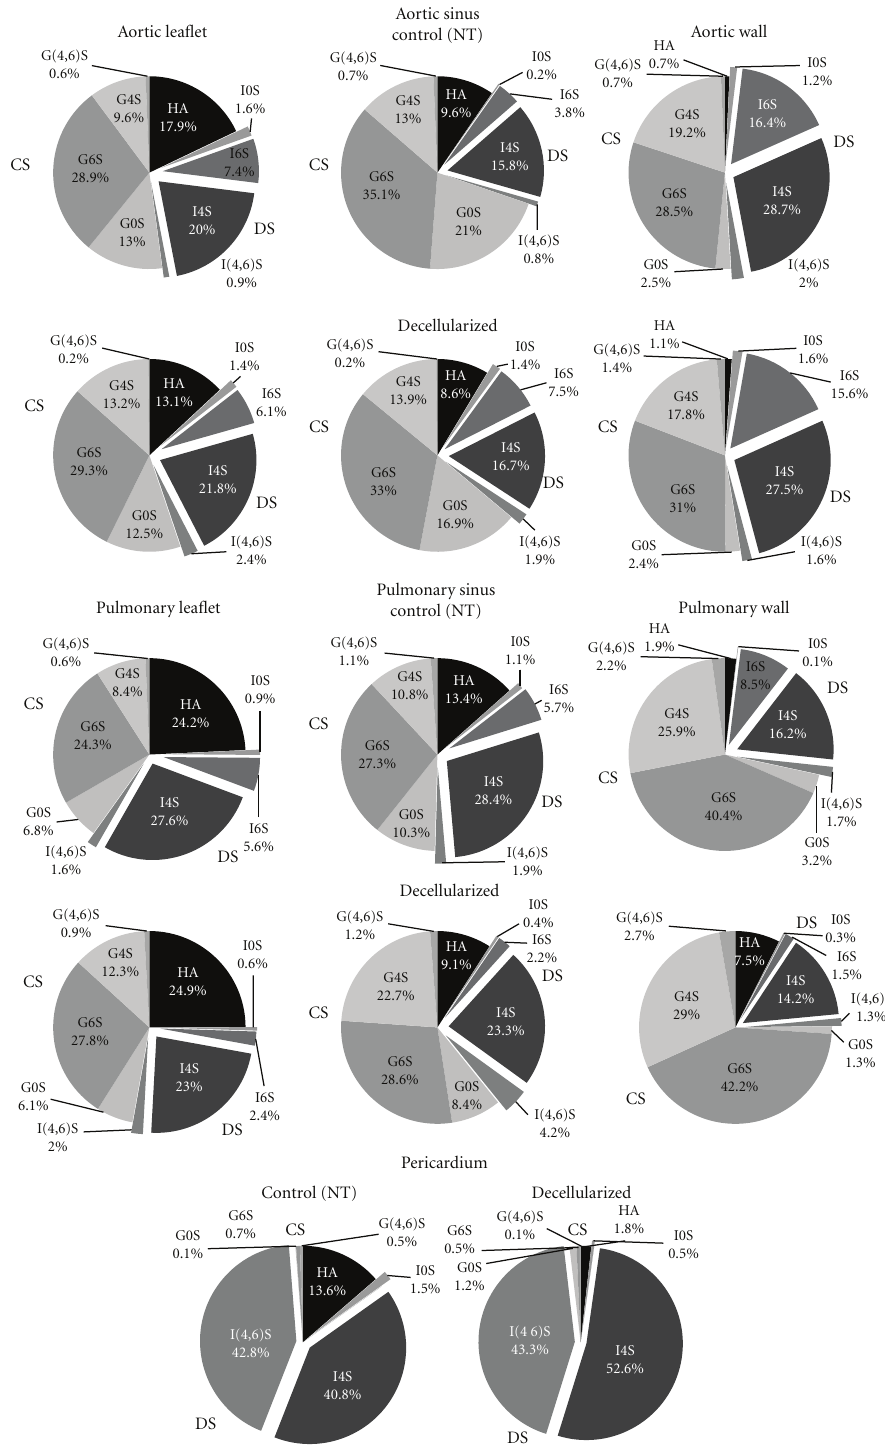
Figure 3: Distribution of glycosaminoglycans (GAGs) in NT and TriCol-treated porcine valves and pericardium, as calculated from FACE data. G0S: nonsulfated GlcA-containing disaccharides, G6S: 6-sulfated GlcA-containing disaccharide, G4S: 4-sulfated GlcA-containing disaccharide, G(4,6)S: disulfated GlcA-containing disaccharide, I0S: nonsulfated IdoA-containing disaccharide, I6S: 6-sulfated IdoA- containing disaccharide, I4S: 4-sulfated IdoA-containing disaccharide, I(4,6)S: disulfated IdoA-containing